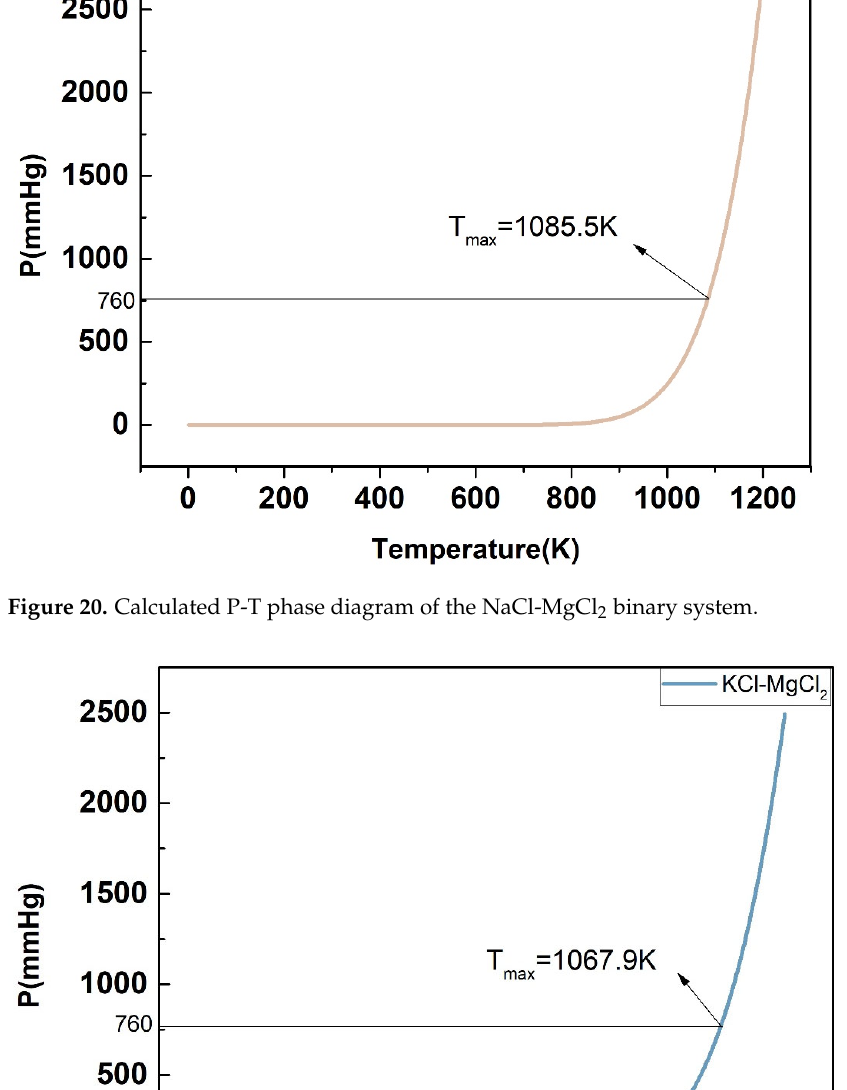
Figure 19. Calculated P ‐ T phase diagram of the KCl ‐ CaCl 2 binary system.